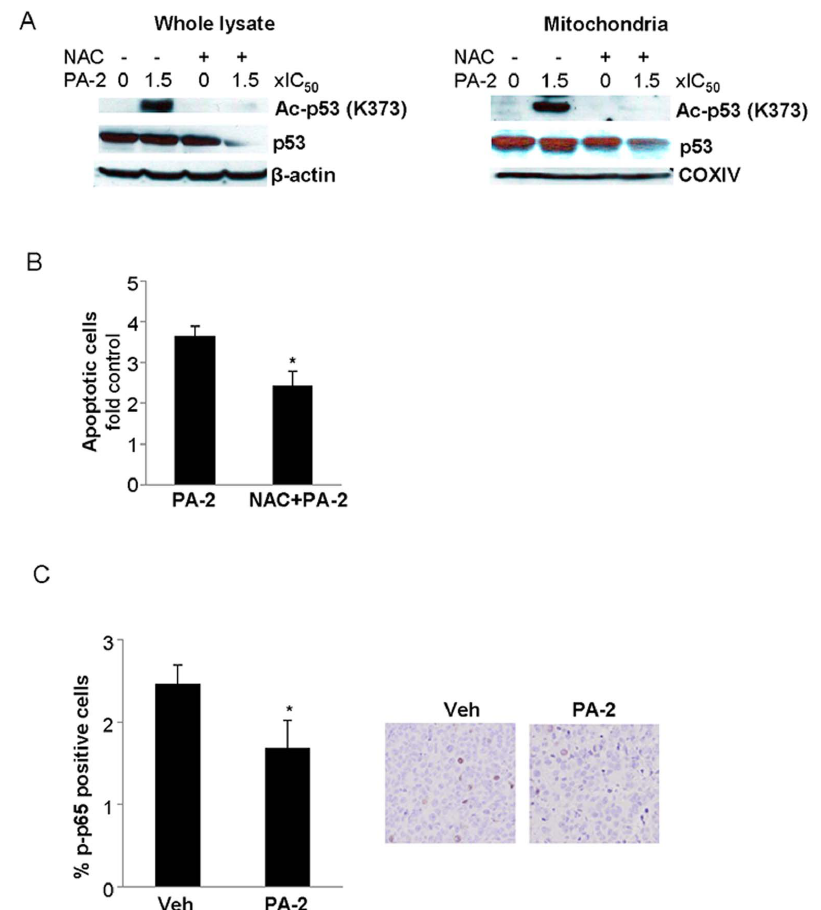
Figure 7. Induction of oxidative stress mediates the effect of phospho-aspirin-2 on p53. A: Left : Levels of total and acetylated p53 in MCF7 whole cell lysate after PA-2 treatment with or without 10 mM N-acetylcysteine. Right : Levels of total and acetylated p53 in MCF7 mitochondria after PA-2 treatment with or without 10 mM N-acetylcysteine. B: Co-incubation of PA-2 with N-acetylcysteine attenuated its apoptotic effect in MCF7 cells. C: Activated NF-kB (p-p65) levels from MCF7 tumors, determined by immunohistochemistry using anti-p-p65 antibody, were suppressed in PA- 2-treated group compared with its vehicle group. The percentage of p-p65 positive cells in 10 fields was determined and averaged for each tumor. * P , 0.05, compared to vehicle. Representative image are shown; magnification 200 x. All values are Mean 6